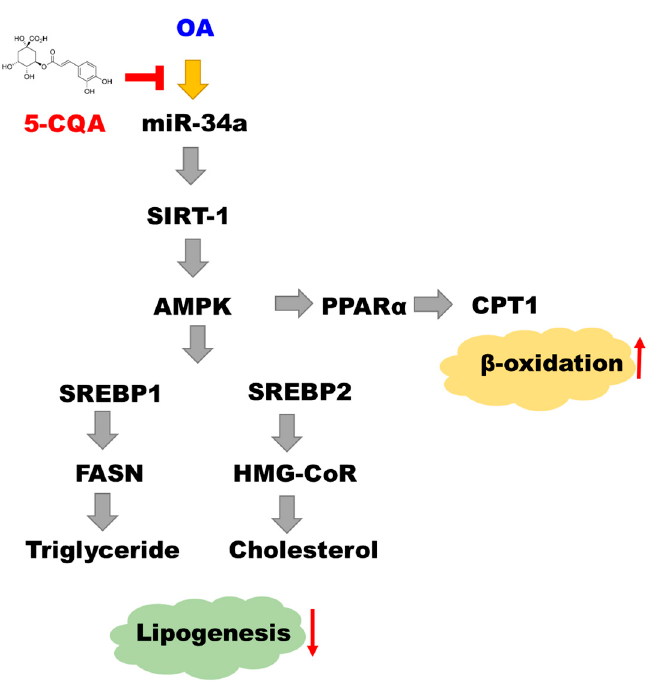
Figure 8. The mechanism by which 5-CQA alleviates lipid accumulation.